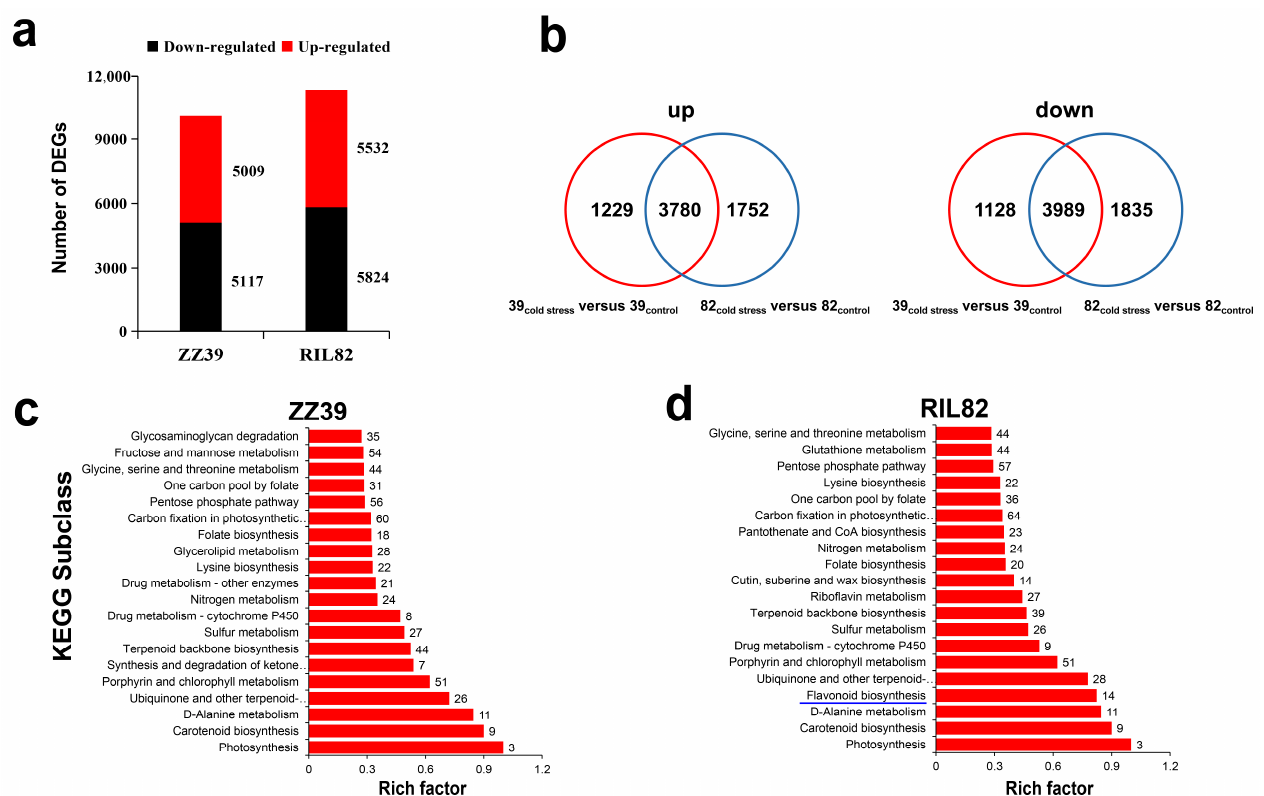
Figure 2. Transcriptome analysis in the two varieties under cold stress. ( a ), Number of DEGs in the ZZ39 and RIL82 genotypes after the cold treatment; ( b ), Venn diagram of upregulated DEGs (left) and Venn diagram of downregulated DEGs (right) in ZZ39 and RIL82; ( c , d ), Down KEGG enriched pathway (Top 20). The abscissa represents the Rich factor, and the ordinate represents the KEGG subclass. The blue line represents the flavonoid pathway played a key role in contributing to the difference in cold tolerance between the two genotypes.